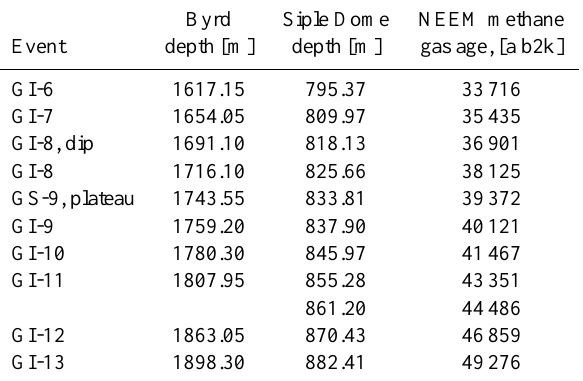
Table A1. Match points between methane depths from the Byrd ice core (Ahn and Brook, 2008; Ahn et al., 2012), the Siple Dome ice core (Brook et al., 2005; Ahn et al., 2012) and NEEM methane (Chappellaz et al., 2013) gas age according to the GICC05 chronol- ogy (Guillevic et al., 2013; Rasmussen et al., 2013). Byrd Siple Dome NEEM methane depth [m] depth [m] gas age, [a b2k]